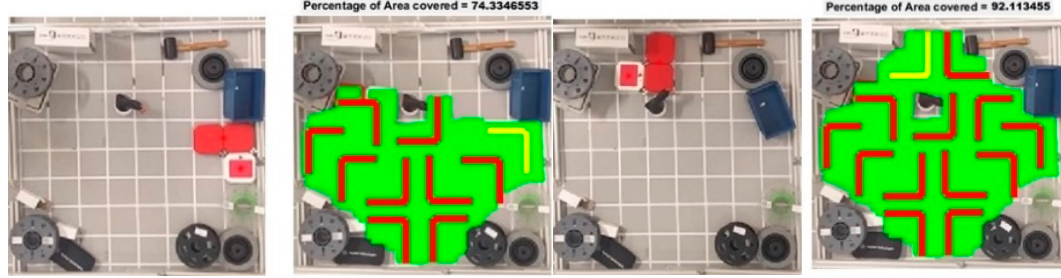
Figure 21. Tiling Process with Lemma 5 tile set.